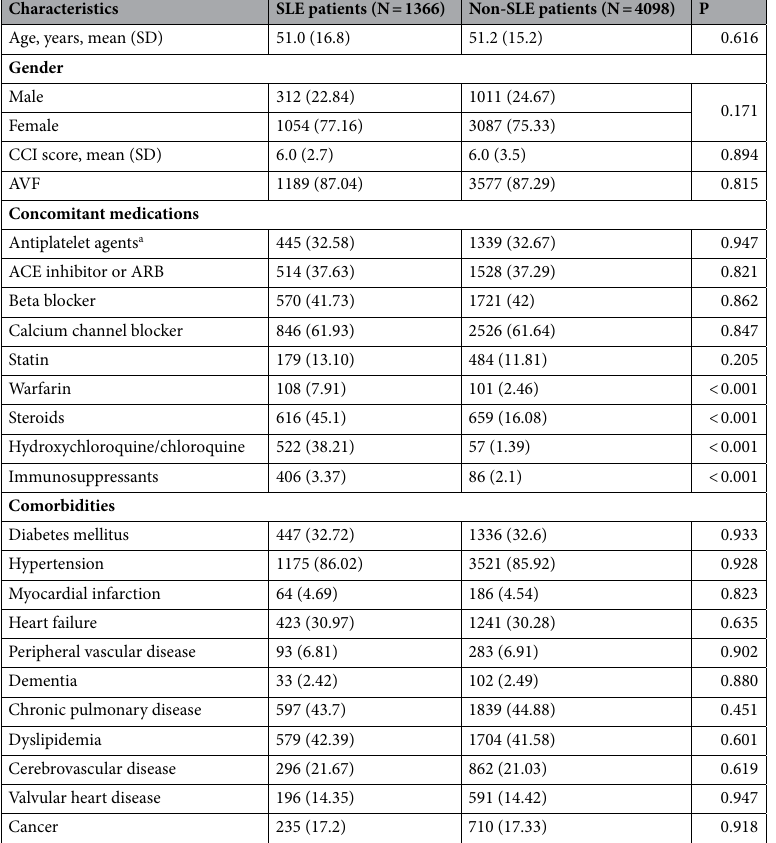
Table 1. Baseline characteristics of patients. All data are presented as n (%), unless otherwise indicated. SLE systemic lupus erythematosus, CCI Charlson comorbidity index, AVF arteriovenous fistula, HD hemodialysis, ACE angiotensin-converting enzyme, ARB angiotensin II receptor blocker, SD standard deviation. a Including aspirin, clopidogrel, ticlopidine, and cilostazol.